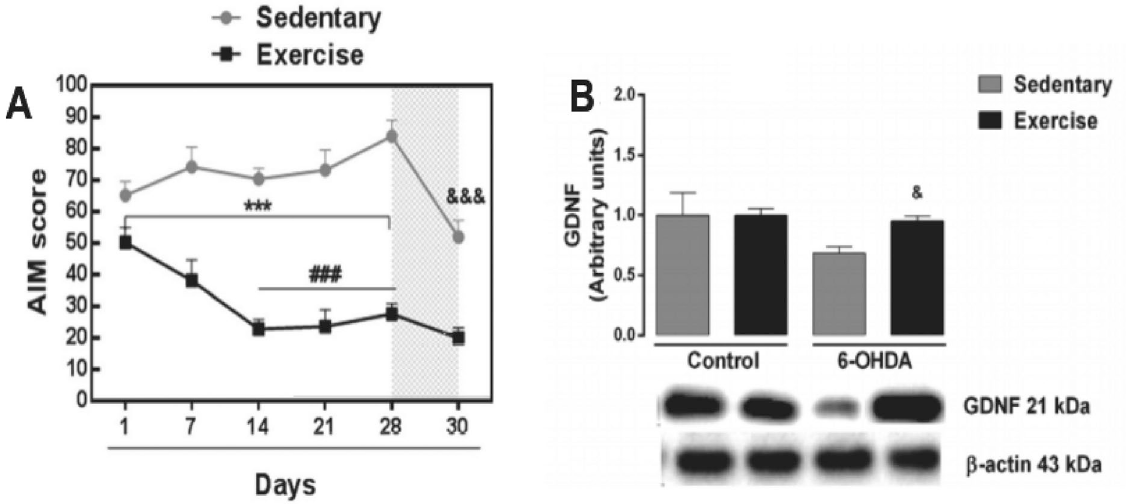
Figure 4 - Exercise (treadmill) or sedentary groups were treated with L-DOPA/Benserazide (50/25 mg/kg, i.p.) for 4 weeks. Exercised mice presented a reduced AIM score from 14th, 21th, and 28th days of treatment (*** P < 0.001 vs. sedentary; ### P < 0.001 vs. exercised on the first day (A). Exercise increased the GDNF immunocontent in the 6-OHDA lesioned striatum of dyskinetic mice (B). AIM, abnormal involuntary movements; GDNF, cell- derived neurotrophic factor; 6-OHDA,